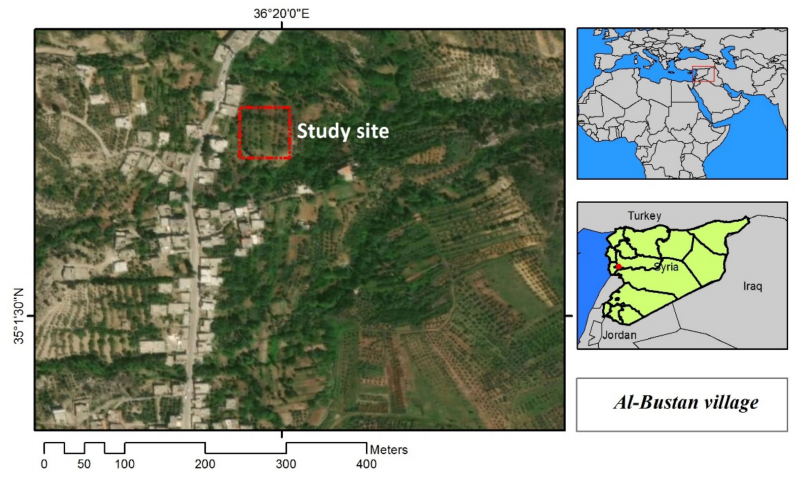
Figure 1. Location of the study area (Mysiafe region, Central